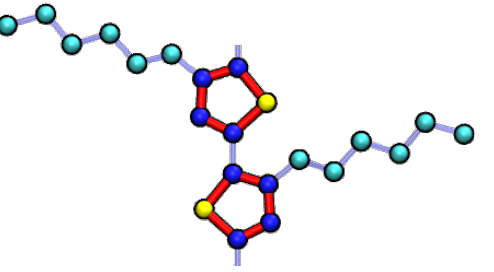
Figure 1. P3HT is modeled in this work with a united-atom representation. Sulfur beads (S) are yellow, aromatic carbon beads (CA) are dark blue, and aliphatic carbons beads (CT) are in cyan. Red bonds indicate thiophene rings modeled as rigid bodies, whereas the light blue indicate harmonic bonds. Table 1. Optimized OPLS-UA interaction parameters for CA, CT, and S simulation elements used in this work. (cid:101) is the depth of the Lennard–Jones well, σ LJ is the van der Waals radius, and m is the